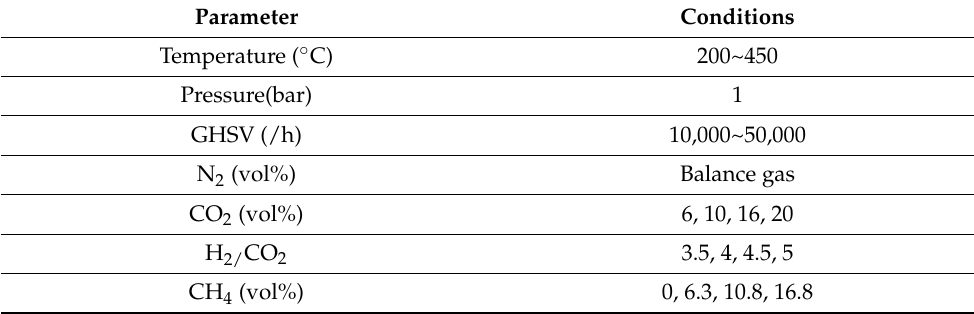
Table 5. Experimental conditions used for the methanation